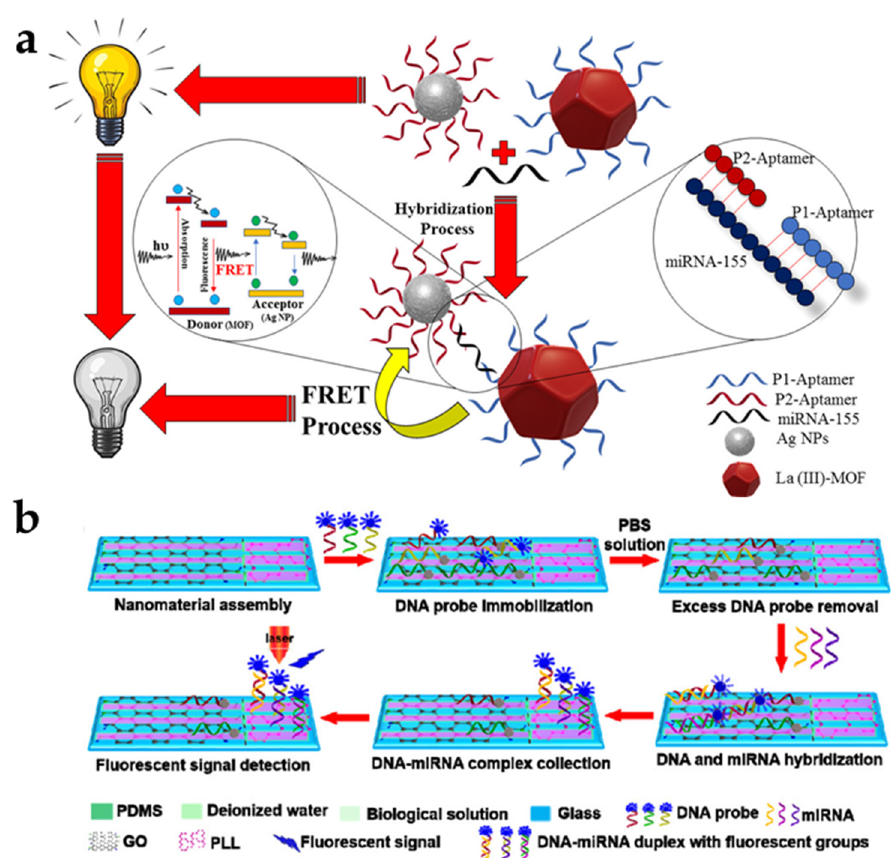
Figure 3. RNA target biosensor using nanomaterial-based FRET. ( a ) Schematic diagram of the FRET- based detection of miRNA-155 as a cancer biomarker by using La (III) metal–organic MOF and AgNPs. This figure is reproduced from [69] (© 2021 American Chemical Society); ( b ) Schematic illustration of the multiplex miRNA-sensing principle of microfluidic biochips via single-stranded probe/DNA–miRNA duplexes and PLL-assembled detection microchambers. This figure is reproduced from [70] (© 2021 American Chemical Society).